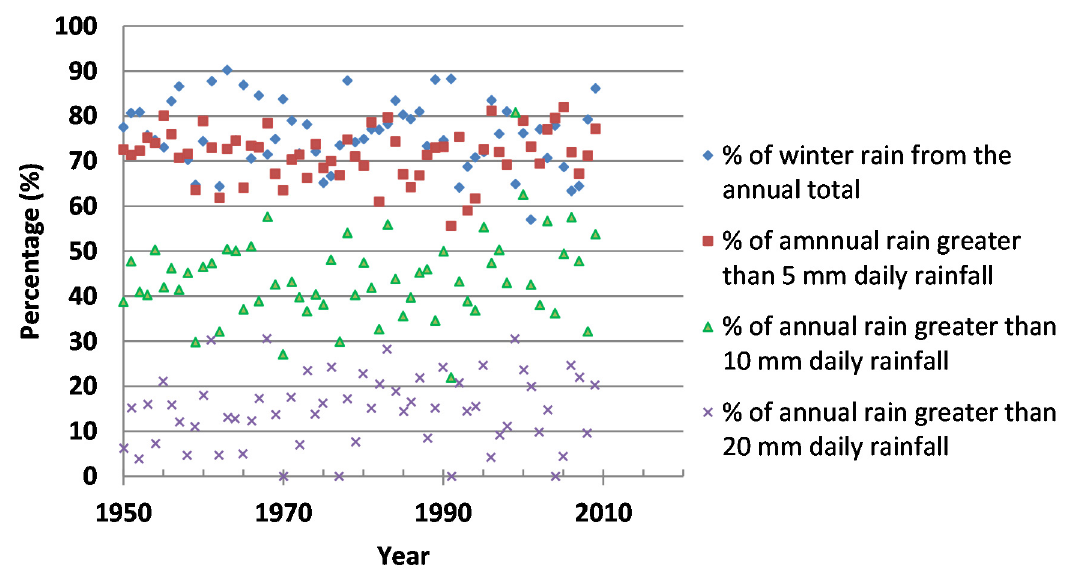
Figure 12. Characteristics of